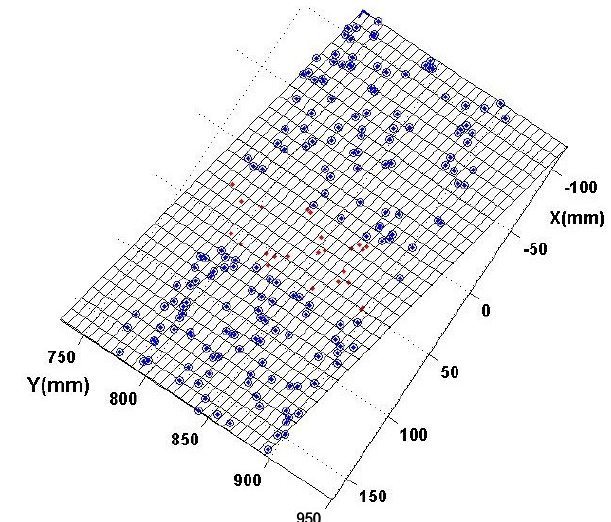
Fig. 3. Randomly selected 200 measured points in one of the experiment (sample set #6) and the optimum substitute plane evaluated by the convex hull approach.